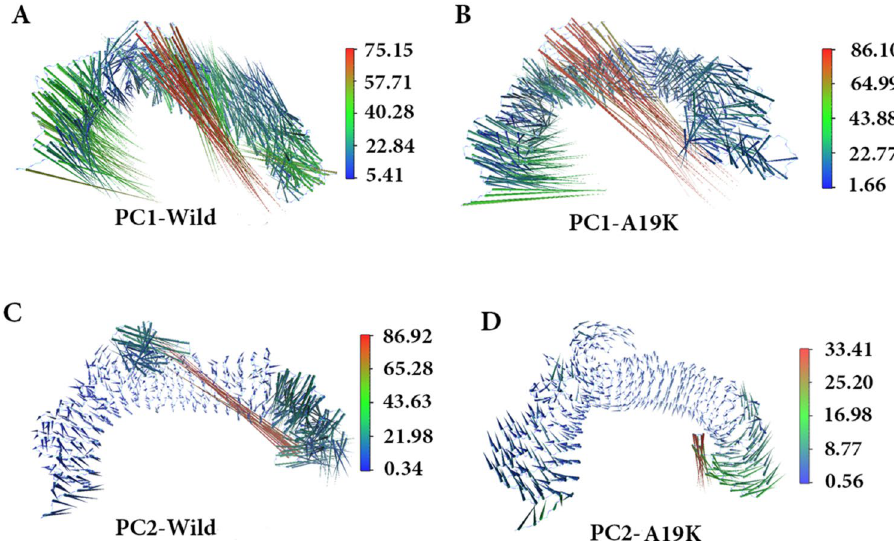
Figure 3. Principal component analysis of Brazzein /hTLR5 complex during the 100 ns of MD. ( A , B ) plot displaying the movement of WT and p.A19K/hTLR5 by analyzing the PC1 from PCA. ( C , D ) Porcupine plot displaying the movement of WT and p.A19K/hTLR5 by analyzing the PC2 from